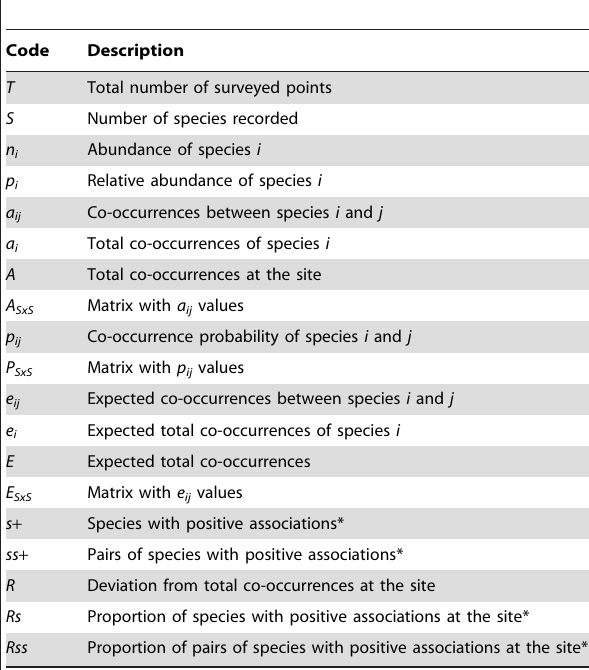
Table 1. Variable and parameter codes employed in the study.